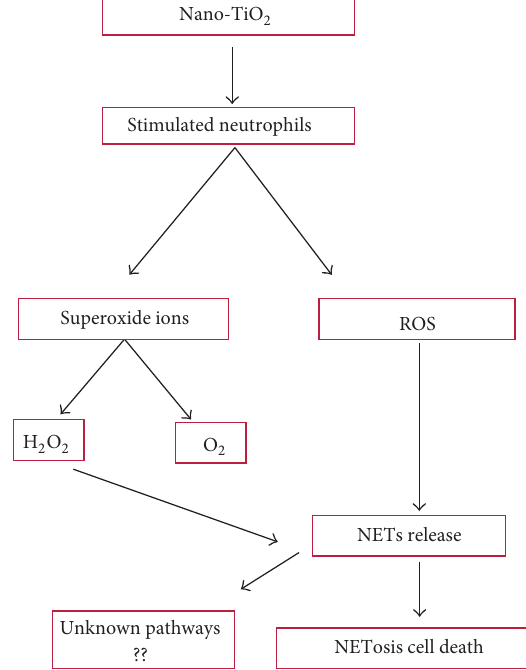
Figure 2: Nano-TiO 2 -induced NETosis cell death